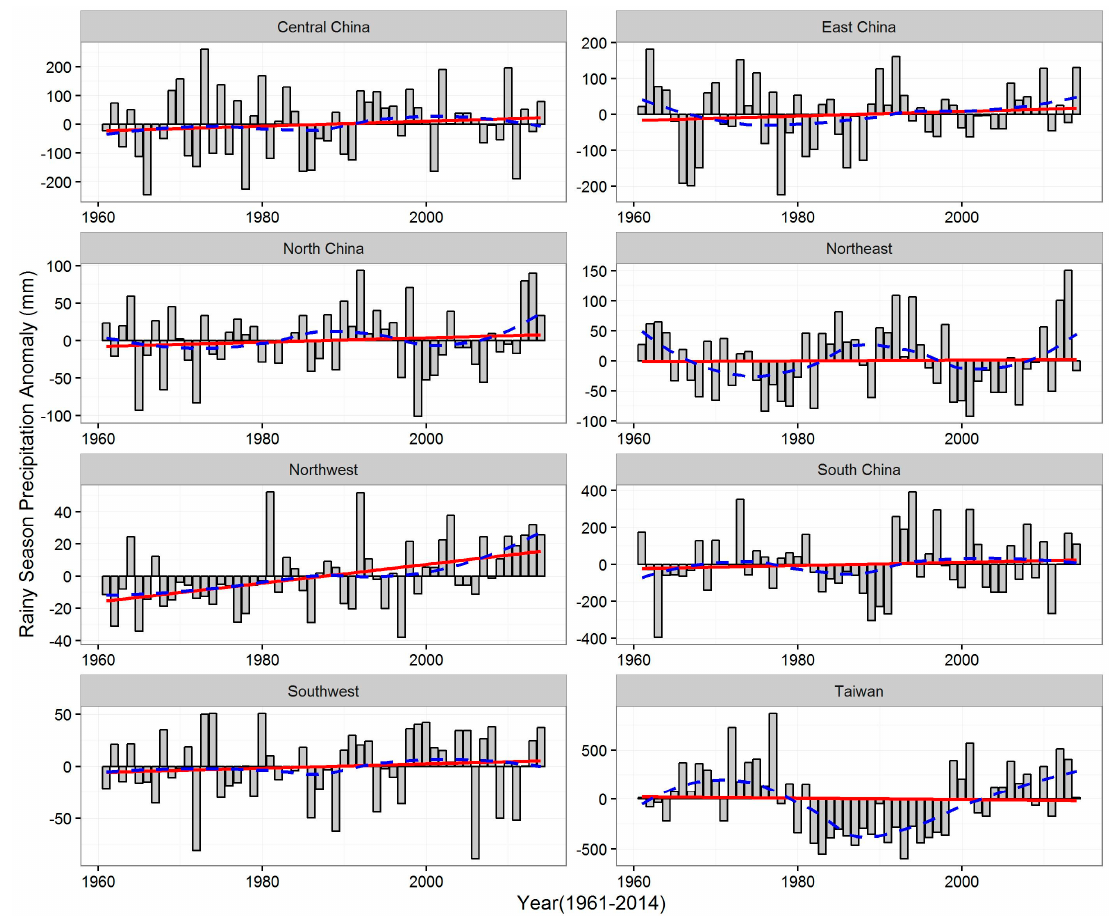
Figure 3. Trend in rainy season (April to September) precipitation anomaly (difference between annual precipitation and long-term average precipitation) from 1961 to 2014 across central China, east China, north China, northeast, northwest, south China, southwest, and Taiwan. Red solid lines indicate linear trend in precipitation anomaly time series, and dashed blue lines show Local Polynomial Regression Fitting (loess regression in R) of rainy season precipitation anomaly.